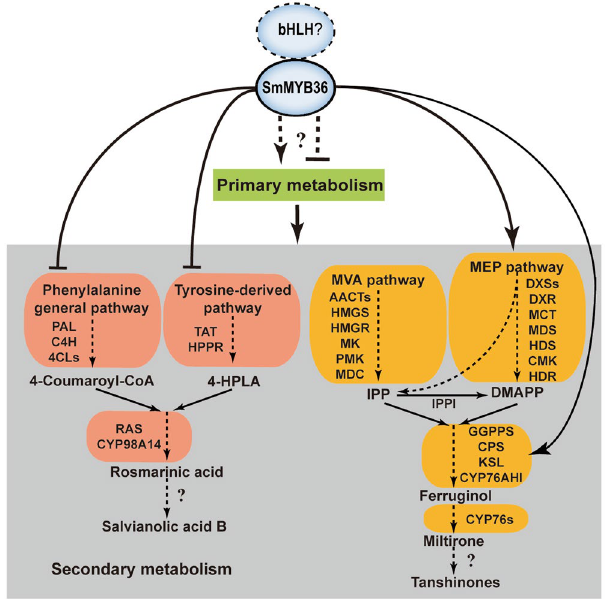
Figure 1. The model for tanshinone and phenolic acid biosynthesis regulation by